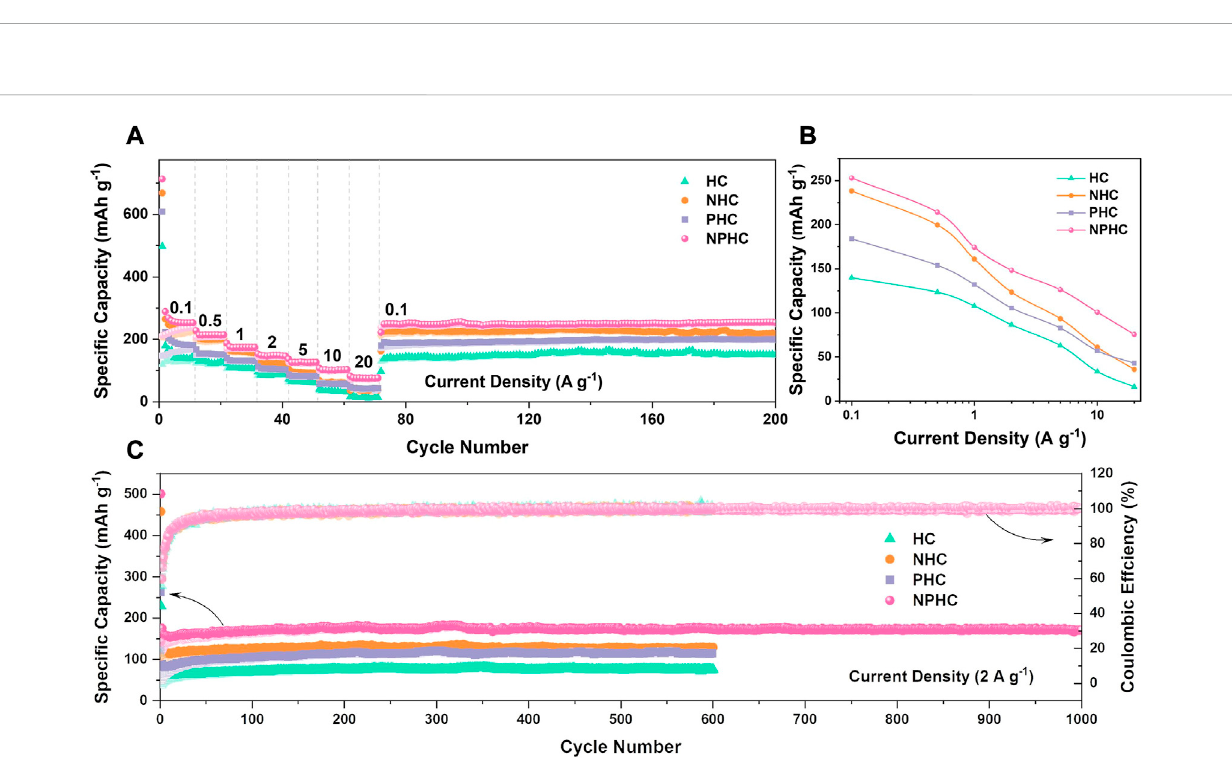
FIGURE 10 Comparison of potassium storage capacity of HC, NHC, PHC and NPHC. (A) Rate capability (B) Speci fi c capacity at different current densities (C) Cycle life of 2 A g -1 (Wang, et al.,